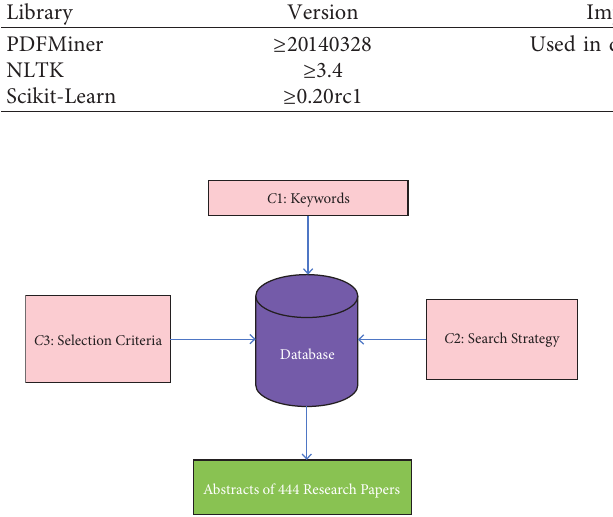
Figure 4: Dataset preparation using 3C’s